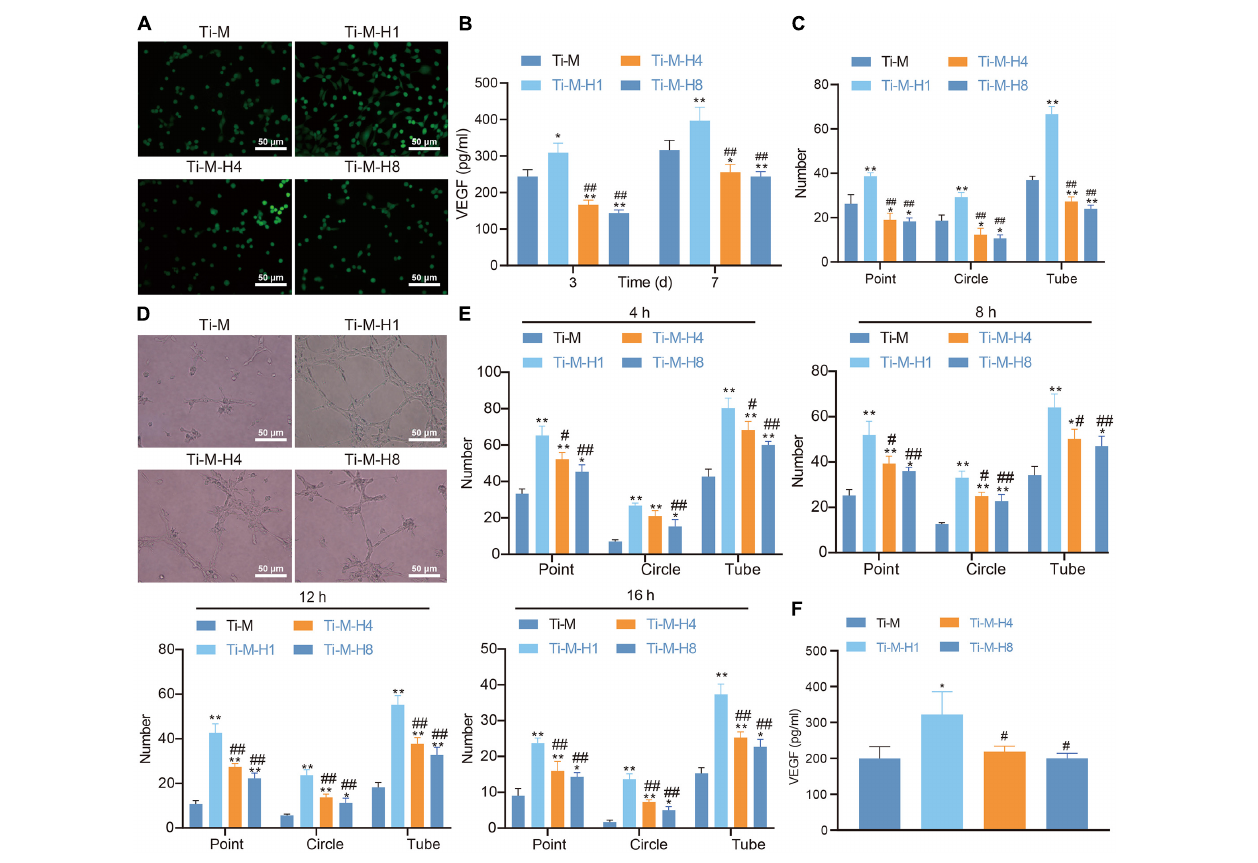
FIGURE 3 | Ti–M–H coating promotes angiogenesis in vitro . (A) Live/dead images of endothelial cells (ECs) cultured on the sample surface for 1, 3, and 5 days. (B) The secretion of VEGF by ECs. (C) Quantitative: the number of nodes, branches, and tube formation formed in capillary-like networks after ECs were incubated in sample extract for 7 h. (D) Images of capillary-like networks by ECs incubated in SCMO for 4, 8, 12, and 16 h. (E) Quantitative: the number of nodes, branches, and tube formation after incubation for 4, 8, 12, and 16 h. (F) VEGF secretion after the ECs were incubated in SCMO for 8 days. * P < 0.05 compared with Ti–M. # P < 0.05 compared with Ti–M–H1. & P < 0.05 compared with Ti–M–H4. ** P < 0.01 compared with Ti–M. ## P < 0.01 compared with Ti–M–H1. && P < 0.01 compared with Ti–M–H4. The experiments were repeated three